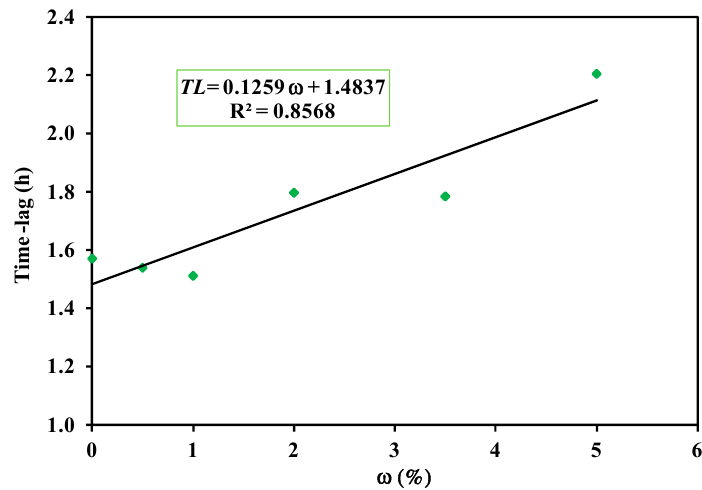
Figure 12. Time-lag variation as function of AF mass content.